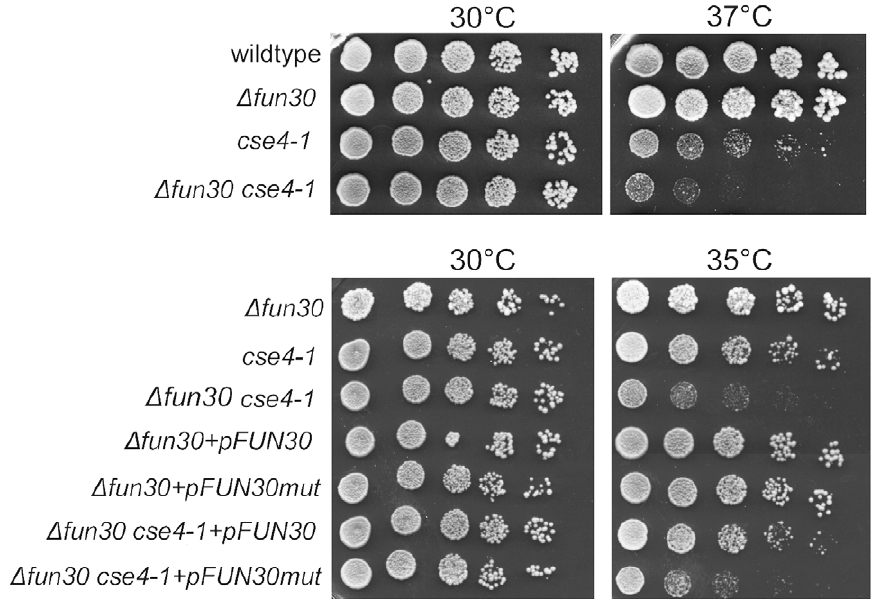
Figure 3. Fun30 is required when Cse4 function is compromised. Growth of the double mutant D fun30 cse4-1 is strongly affected at semi- restrictive temperatures. Fivefold dilutions of wildtype (BY4741/Y00000), D fun30 (Y00389), cse4-1 (AHY666) and D fun30 cse4-1 (SC53) cells were plated onto YPD plates and incubated at indicated temperatures for 3 days. Lower panels: Fun30 activity is restored by expressing wildtype Fun30 in trans , but not Fun30 with a point mutation in the ATPase domain; Cells were spotted on media with 2% glucose and grown for 3 days at 30 u C or 35 u C.